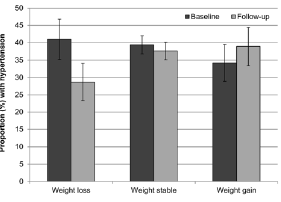
Figure 2. Prevalence of low wellbeing at baseline and follow- up by weight change status. Values are mutually adjusted for age, sex, wealth, and weight loss intention. Error bars represent the 95% confidence interval.